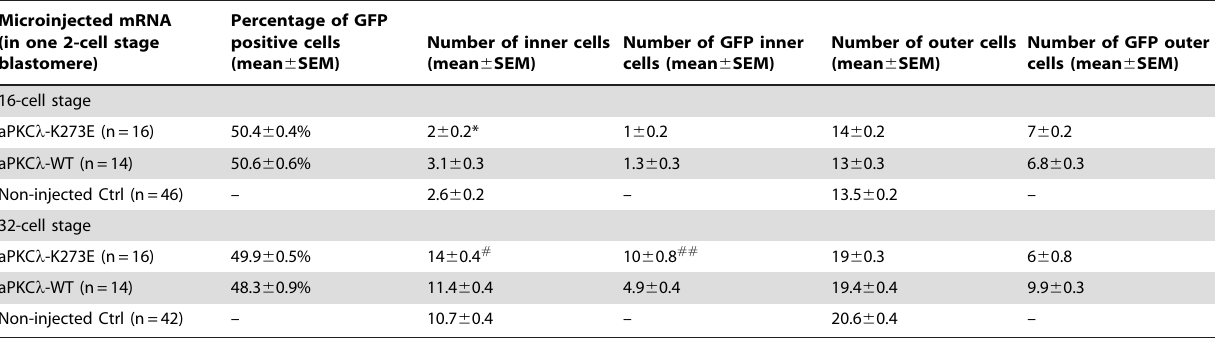
Table 3. Effect of mosaic aPKC l -inactivation on cell allocation at 16-cell stage.